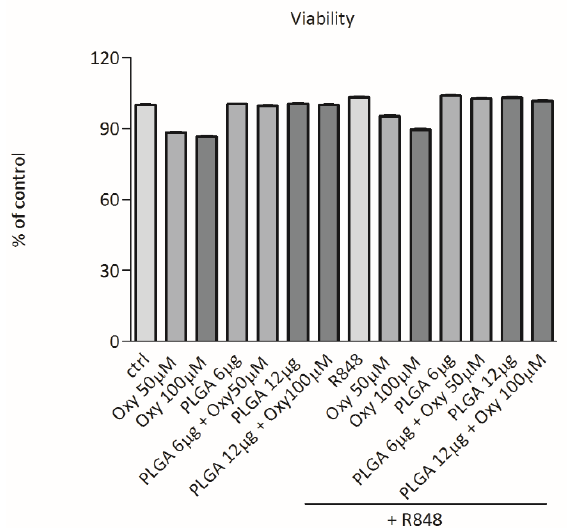
Figure 4. Effects of free oxyresveratrol and oxyresveratrol-bearing PLGA nanoparticles on DC viability. DCs were treated or not treated (ctrl) with the indicated doses of free oxyresveratrol (Oxy), unloaded PLGA nanoparticles (PLGA), or oxyresveratrol-bearing PLGA particles (PLGA + Oxy) for 24 h, followed by 1 h incubation with WST. Values are expressed as the percentage of WST reduction relative to untreated cells (designated as 100%). Data are means ± SD of four experi- ments.